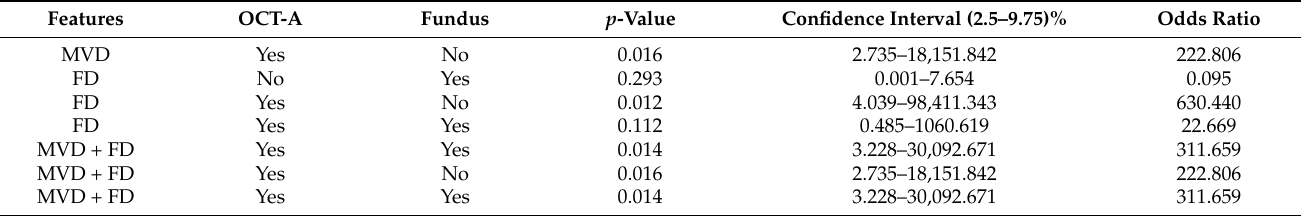
Table A1. p -values and odds ratios of different features and their combinations on age controlled subjects. The columns OCT-A and Fundus represent which images were used to obtain the